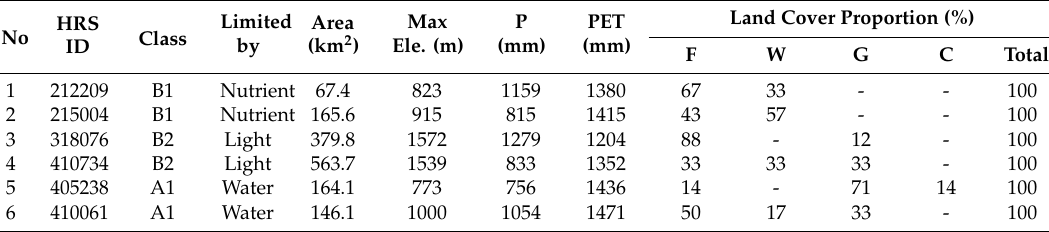
Table 1. Details of Six Catchments Used for SM and ET Simulations in this Study.